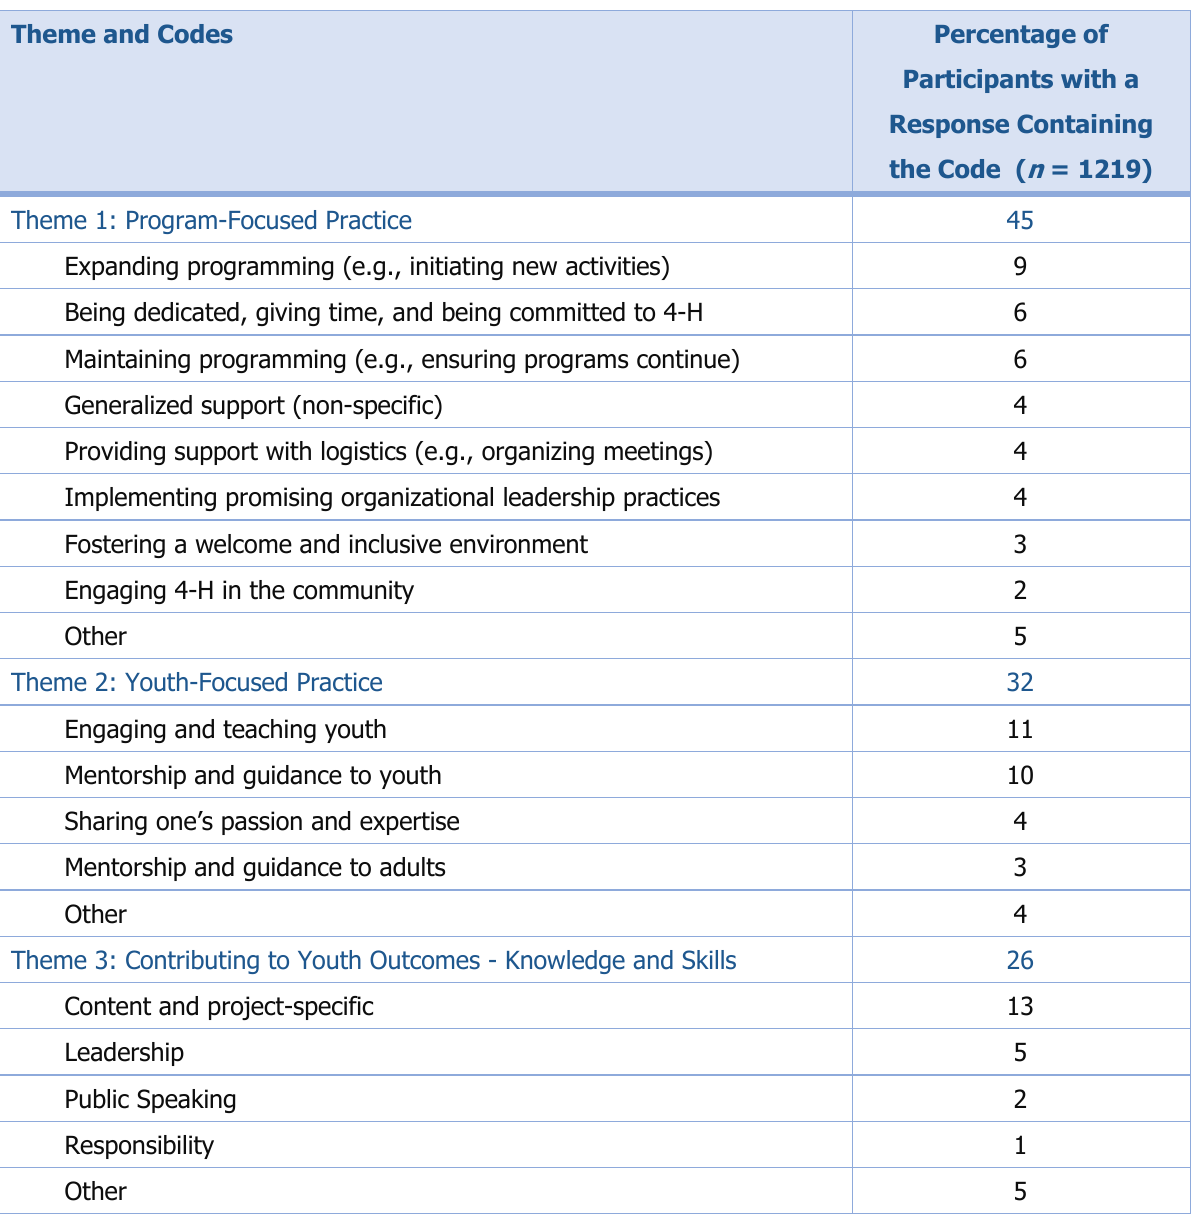
Table 2. Volunteer Impact Themes Theme and